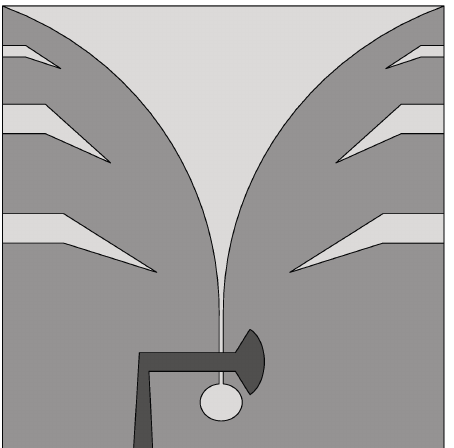
Figure 9. Geometrical layout of side slot-loaded Vivaldi antenna (redrawn from [60]). Dark gray top metal face, medium gray bottom metal face, and light gray dielectric